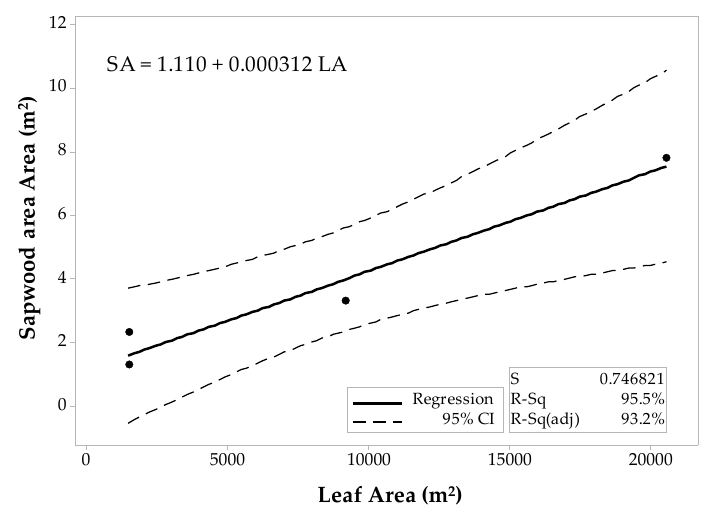
Figure 6. Fitted linear regression model for the 60 × 60 m stands of conifers, SA plot in relation to its LA plot .